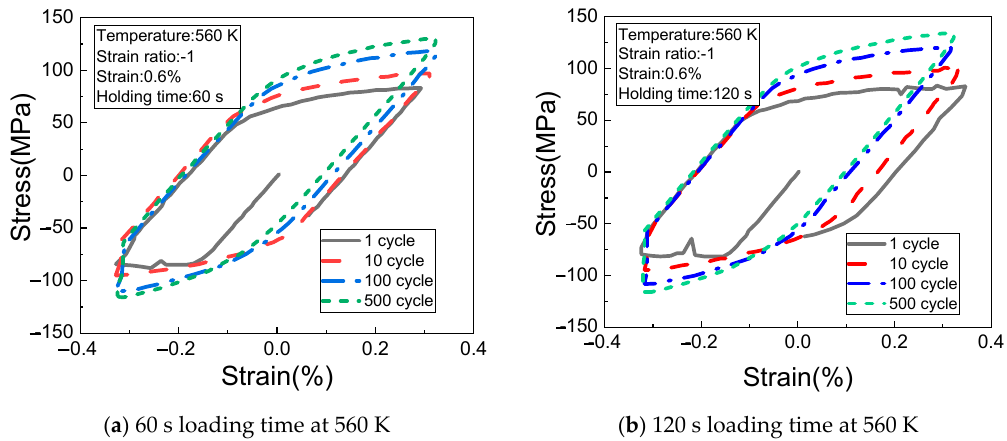
Figure 7. Results of different loading times at 560 K. ( a ) 60 s loading time at 560 K; ( b ) 120 s loading time at 560 K.